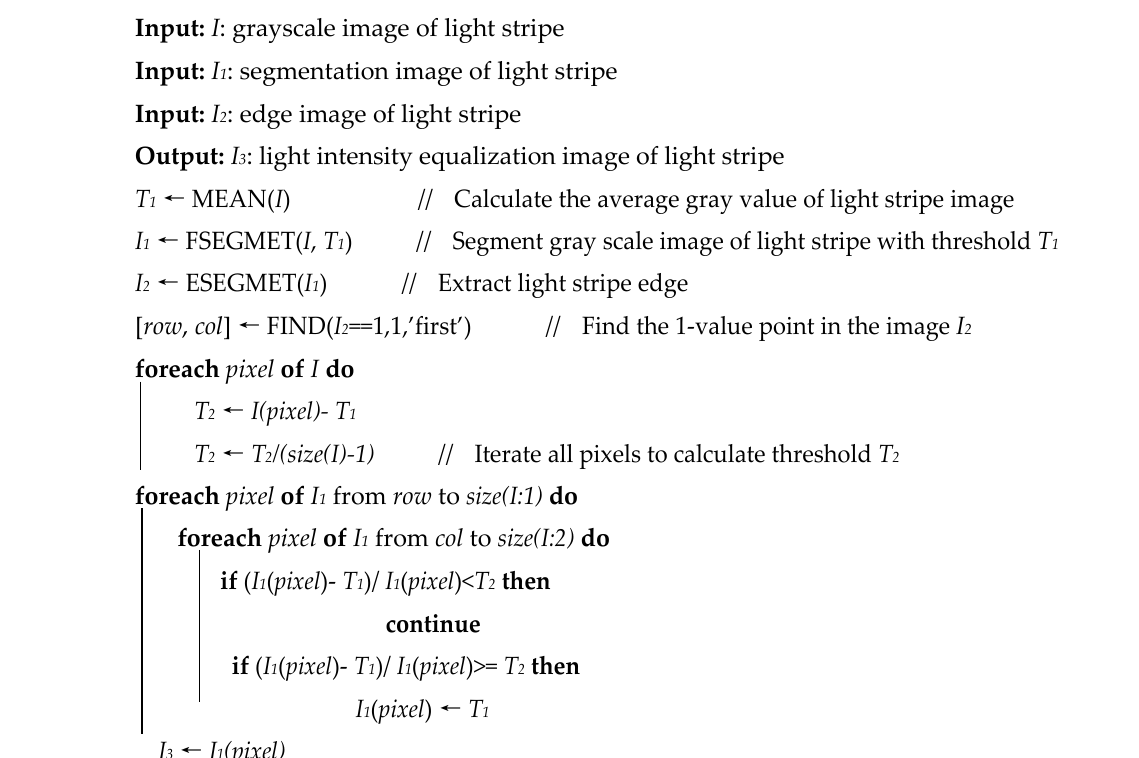
Algorithm 1: Pseudo-code of Light Intensity Equalization Algorithm Algorithm 1 Pseudo-code of Light Intensity Equalization